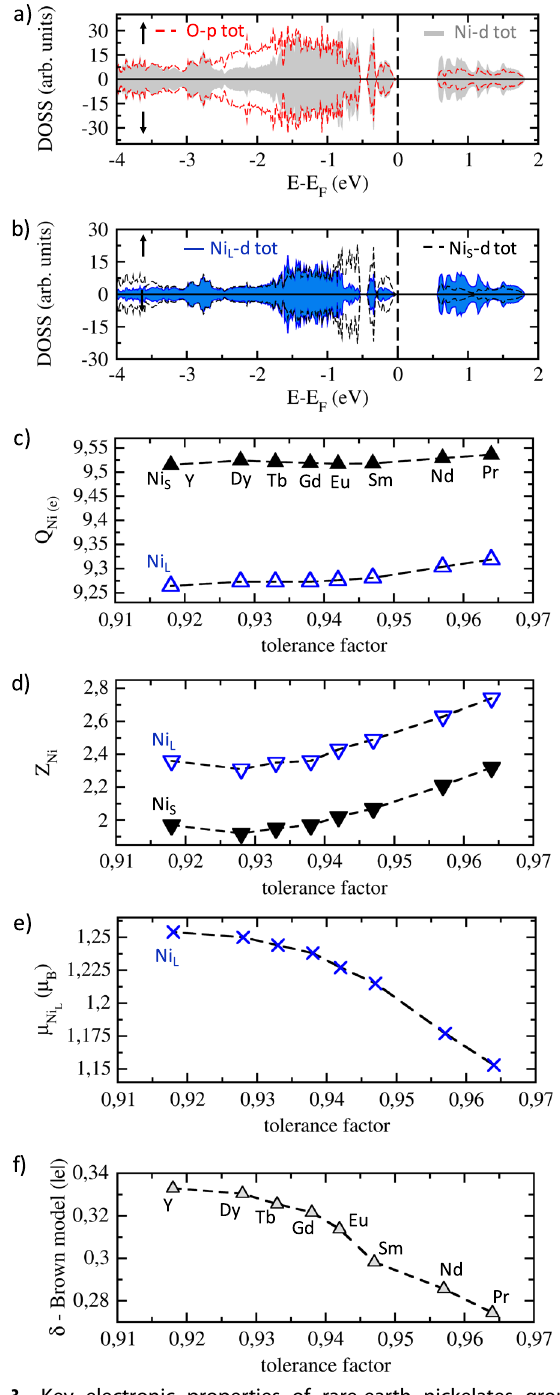
Fig. 3 Key electronic properties of rare-earth nickelates ground state. a , b Total and projected spin-polarized density of states (arbitrary units). The Fermi level is located at 0 eV. The upper (lower) panels correspond to spin-up ( down ). c Total number of electrons ascribed to both Ni sites during the sphere integrations. d Average BECs of both Ni sites. e Computed magnetic moment (in μ B ) of the Ni L site. The magnetic moment of Ni S is exactly zero in the calculation. f Charge disproportionation δ extracted from the empirical Brown valence bond